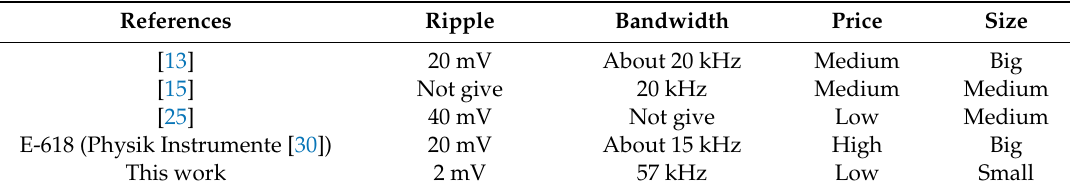
Table 1. Comparisons between the proposed power amplifier and some existing power amplifiers.